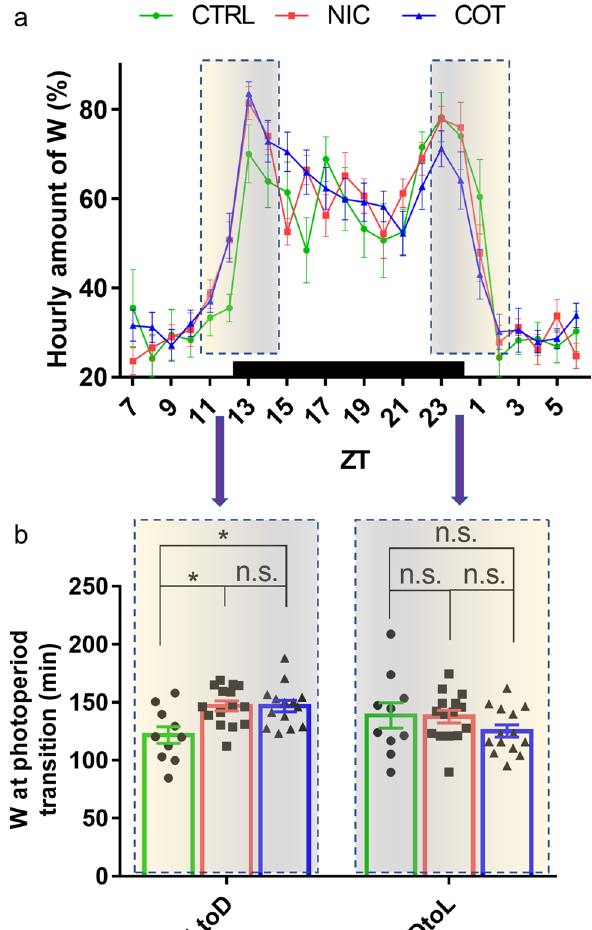
Figure 3. Day-night hourly profiles of the time spent in wakefulness during baseline recordings. Panel ( a ) shows the 24-h hourly profile of the time spent in wakefulness (W) during baseline recordings for adult male mice perinatally exposed to nicotine (NIC, n = 15), cotinine (COT, n = 14) or just the vehicle (CTRL, n = 10). Mice were left undisturbed with lights on at 9.00 a.m. (Zeitgeber Time 0, ZT0) and lights off at 9.00 p.m. (ZT12). Panel ( b ) shows the amount of W in the 4 h surrounding the photoperiod transitions. In particular, values for light to dark (LtoD, ZT10–ZT14) and dark to light (DtoL, ZT22–ZT2) transitions are shown. * p (adjusted for multiple comparisons) < 0.05; n.s., not